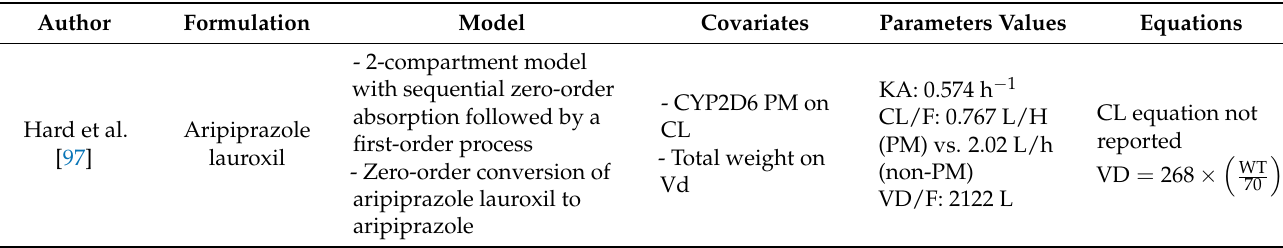
Table 6. Population pharmacokinetic model of LAI